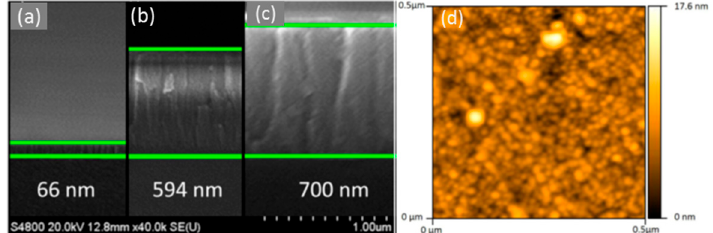
Figure 23. Thickness of sputtered SnO 2 thin layers depending on the deposition time: ( a ) 30 s, ( b ) 3 min and ( c ) 4 min (inset, the measured thickness); ( d ) AFM image of coating ( b ), which shows a RMS roughness of 1.5 nm. Reprinted from [105] with the permission from Elsevier.